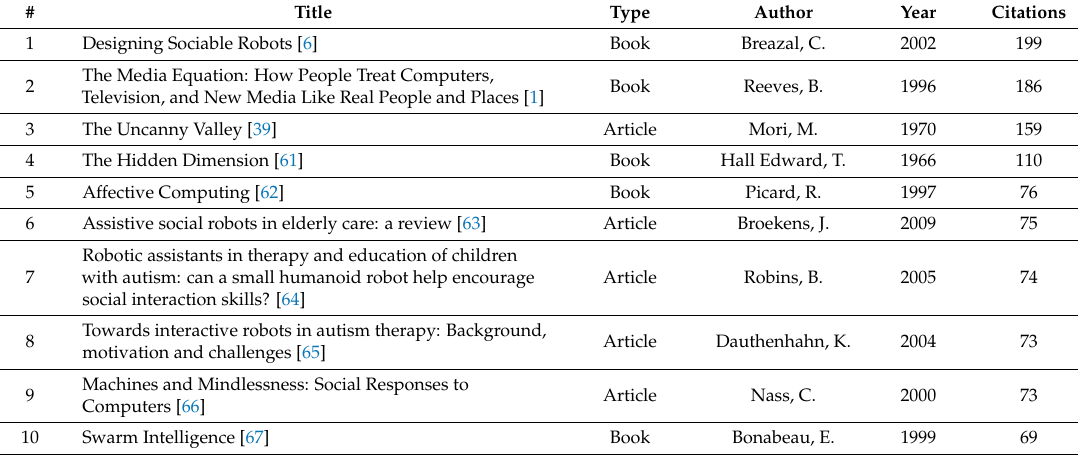
Table 8. Most cited literature from the social robotics research to outside of the network of